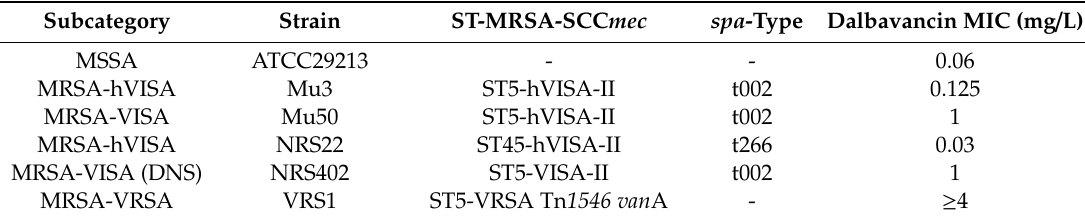
Table 2. In vitro activity of dalbavancin versus S. aureus control strains. Figure 1. E-MRSA15 ST22-IVh-t223 MIC (1X) 0.03mg/L: ( a ) Graph of curves obtained. ( b ) Average of